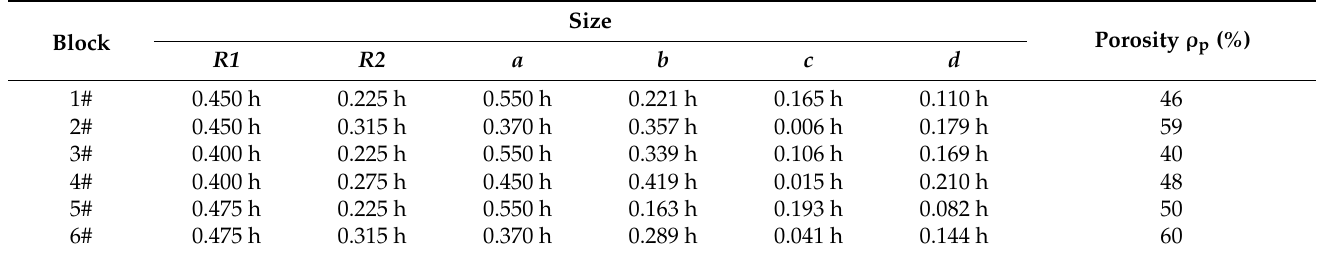
Table 2. Size of the TB-CUBE